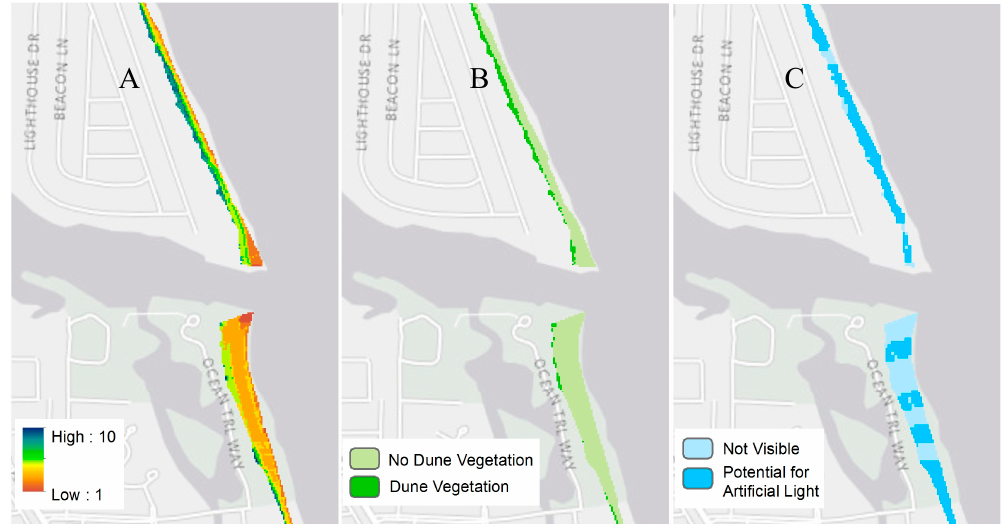
Figure 8. Nesting suitability, Model 17 ( A ); approximate dune vegetation ( B ); and potential artificial light pollution ( C ).